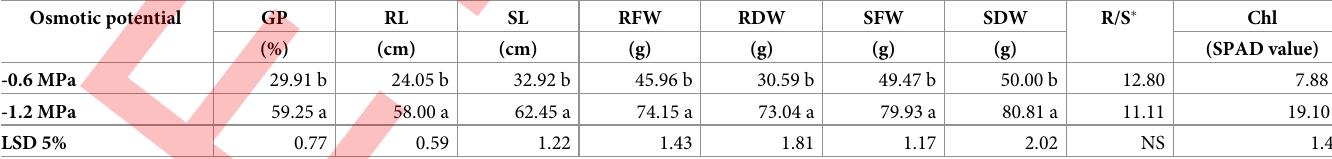
Here, GP = seed germination percentage, RL = root length, SL = shoot length, RFW = root fresh weight, RDW = root dry weight, SFW = shoot fresh